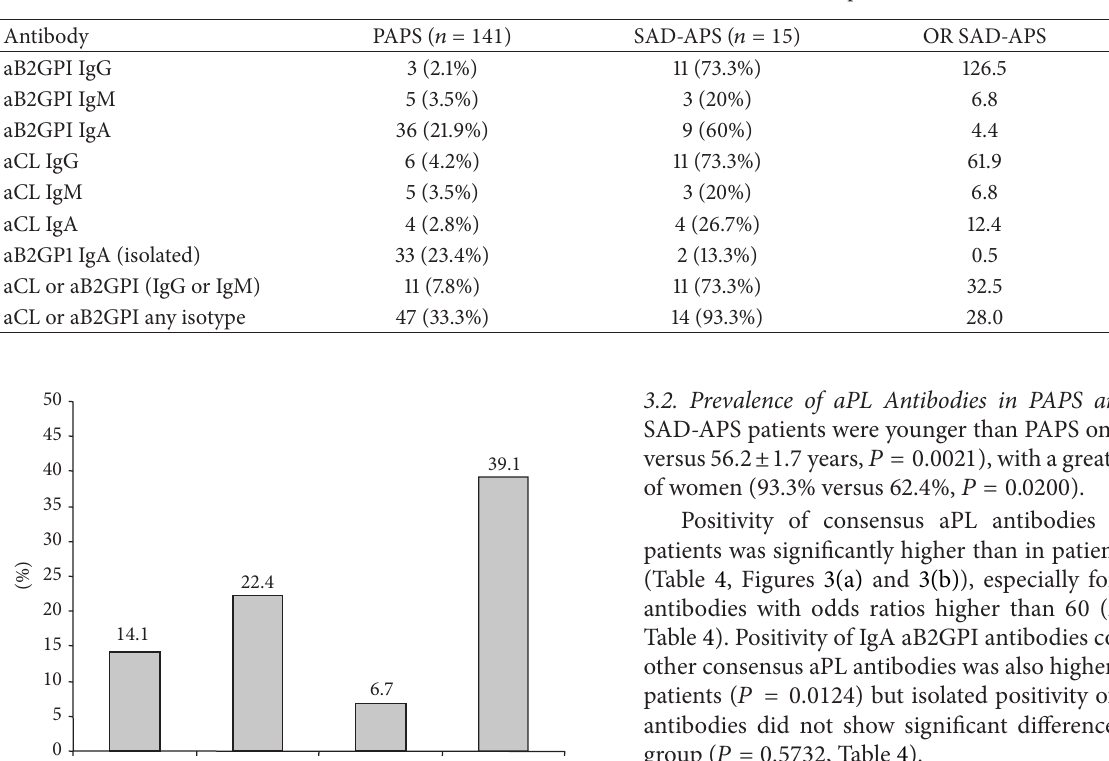
Table 4: Positive aPL antibodies in PAPS versus SAD-APS patients.